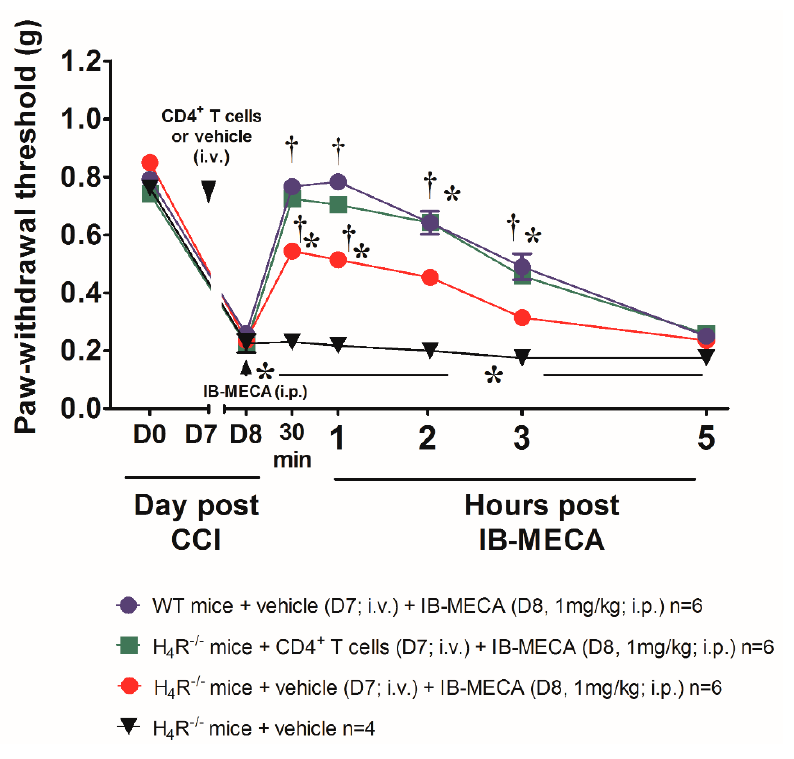
Figure 6. Effect of A 3 AR agonist IB-MECA after CD4 + T cells transfer in H 4 R − / − mice underwent to CCI. Sciatic nerve ligation was performed in H 4 R − / − mice 7 days before the intravenously administration of CD4 + T cells (2 × 10 6 /200 µ L/mouse) obtained from naïve WT mice, 24 h the acute injection of IB-MECA (1 mg/kg, i.p.) was performed. The response to a non-noxious mechanical stimulus was assessed by the Von Frey test. Measurements were performed before and 30 min, 1 h, 2 h, 3 h and 5 h after compounds administration. Data are mean ± SD for n mice per group; * p < 0.05 vs. Day 0 by two-way ANOVA with Dunnett’s test; † p < 0.001 vs. Day 8 by two-way ANOVA with Tukey’s comparisons.